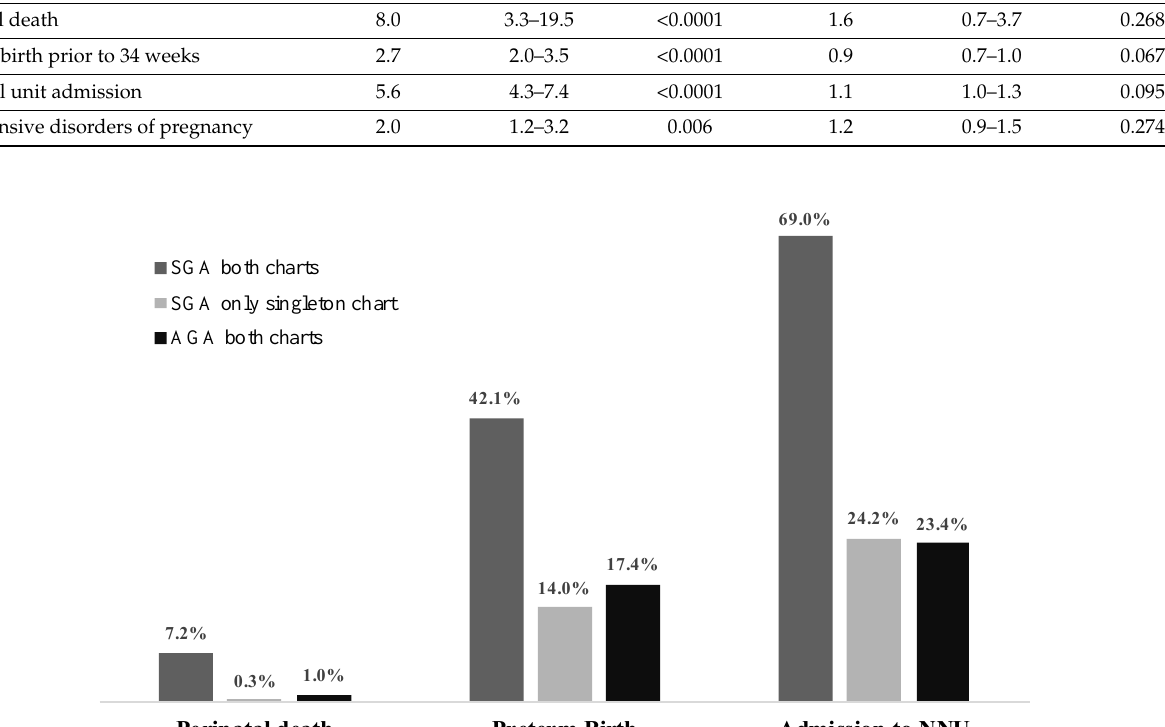
* The results of Chi-square test are presented. Table 3. The association between small for gestational age (SGA) and adverse perinatal outcomes according to whether SGA was defined using the twin vs. singleton chart. Adverse Outcomes